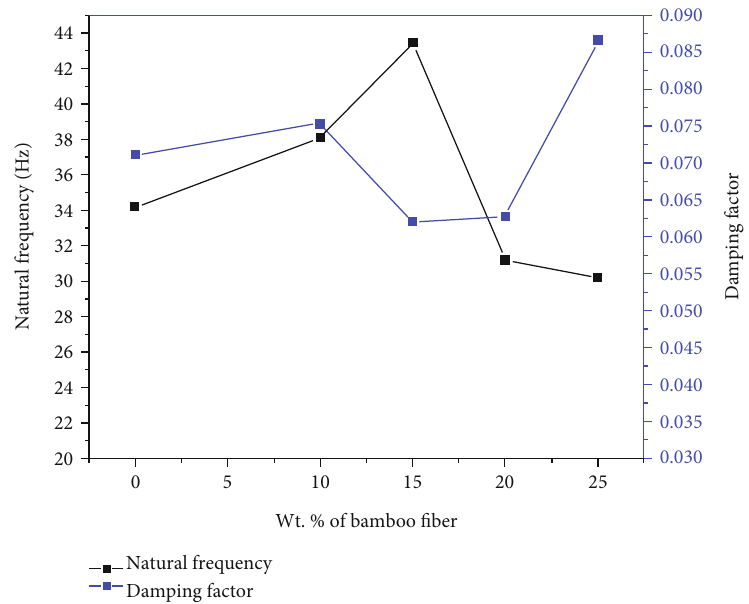
Figure 6: Natural frequency and damping factor with varying bamboo fi ber wt.% (mode